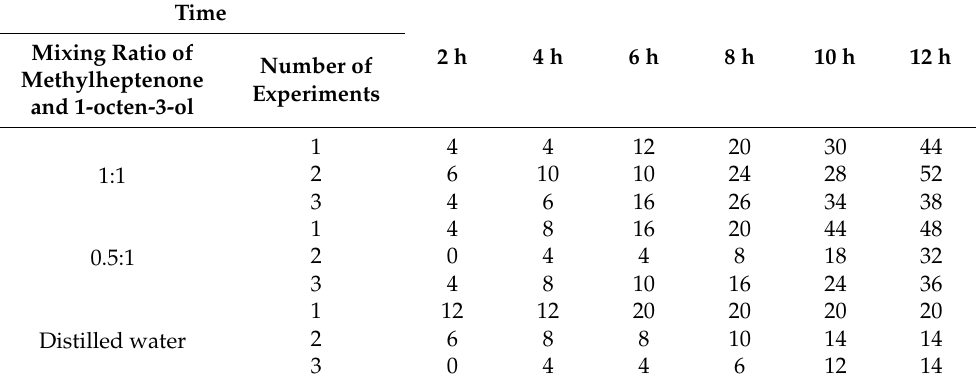
Table 9. Statistical table of the trapping for male W. magnifica by mixing methylheptenone and 1-octen-3-ol in different